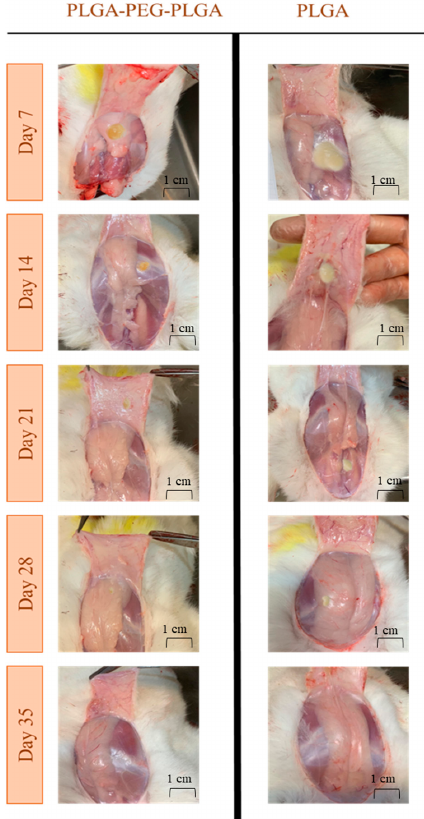
Figure 6. Formation and degradation of ISFG gel and ISFI implant after SC injection into the backside of the rabbit’s neck.